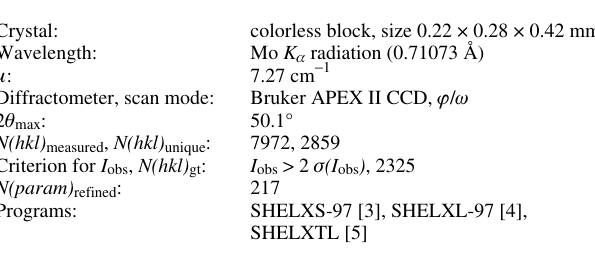
Table 1. Data collection and handling.